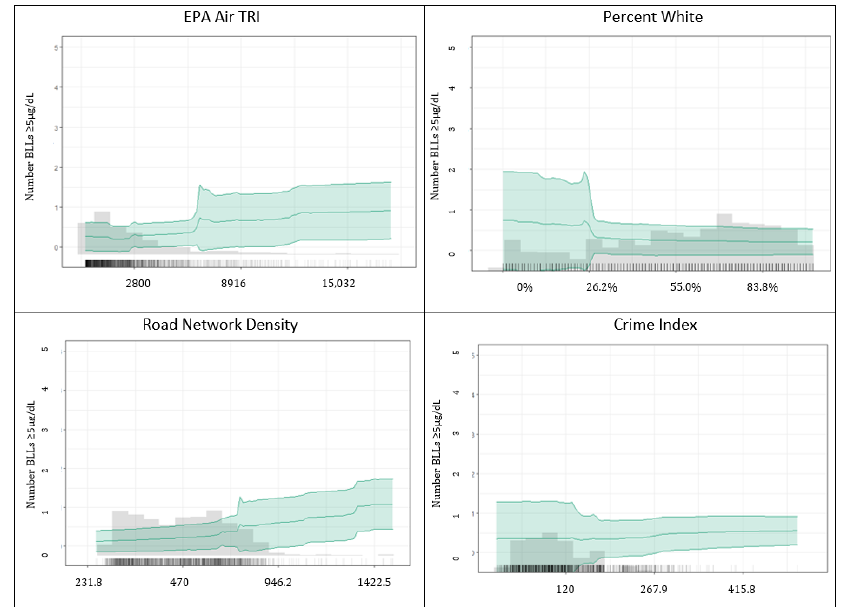
Figure 6. Partial dependence plots for top four ensemble predictors of the number of children in a raster cell with BLLs ≥ 5 µg/dL.